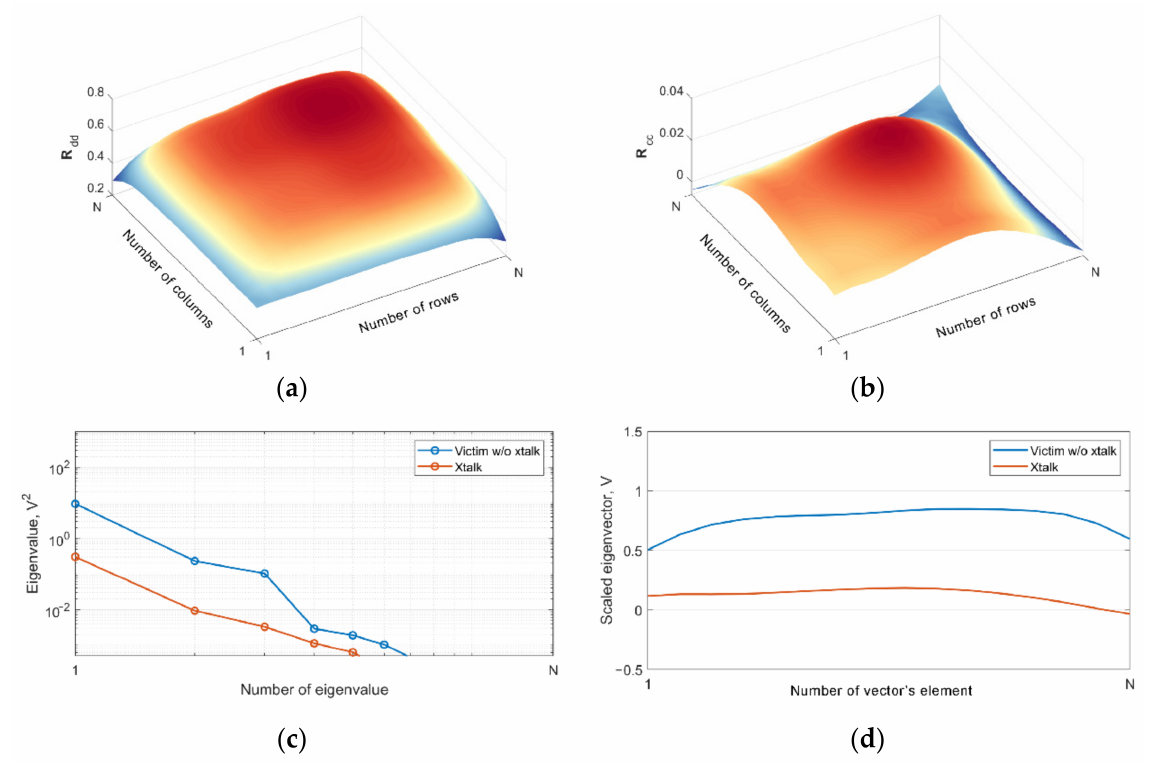
Figure 11. ( a ) The correlation matrix R dd of the victim signal without crosstalk; ( b ) the correlation matrix R cc of the crosstalk interference signal. ( c ) The eigenvalues of the correlation matrices R dd and R cc . ( d ) The scaled eigenvectors of the correlation matrices. Bit rate is 2.5 Gbit/s.